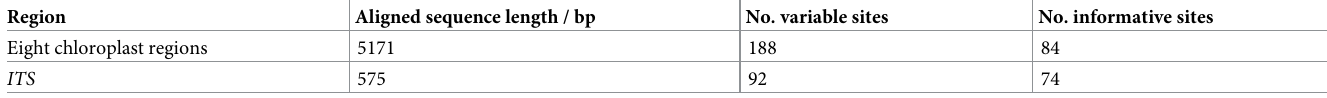
Table 1. Length and number of variable and informative sites identified in the combined chloroplast and ITS regions. Region